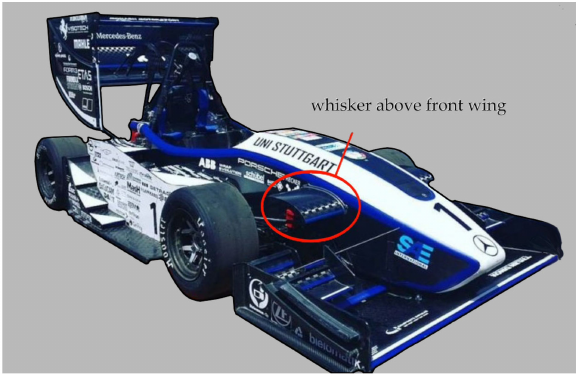
Figure 1. Design for controlling the side air flow using a whisker.